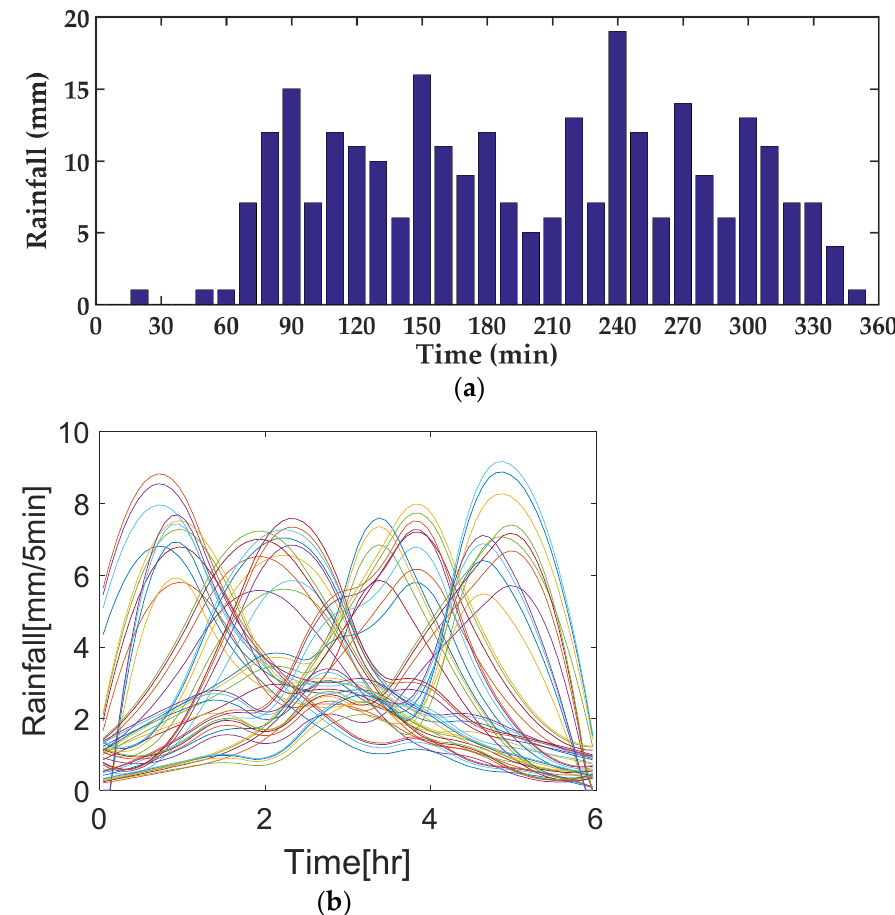
Figure 2. ( a ) Actual rainfall sample on 21 September 2010 and ( b ) 6-h extreme Huff rainfall sample.